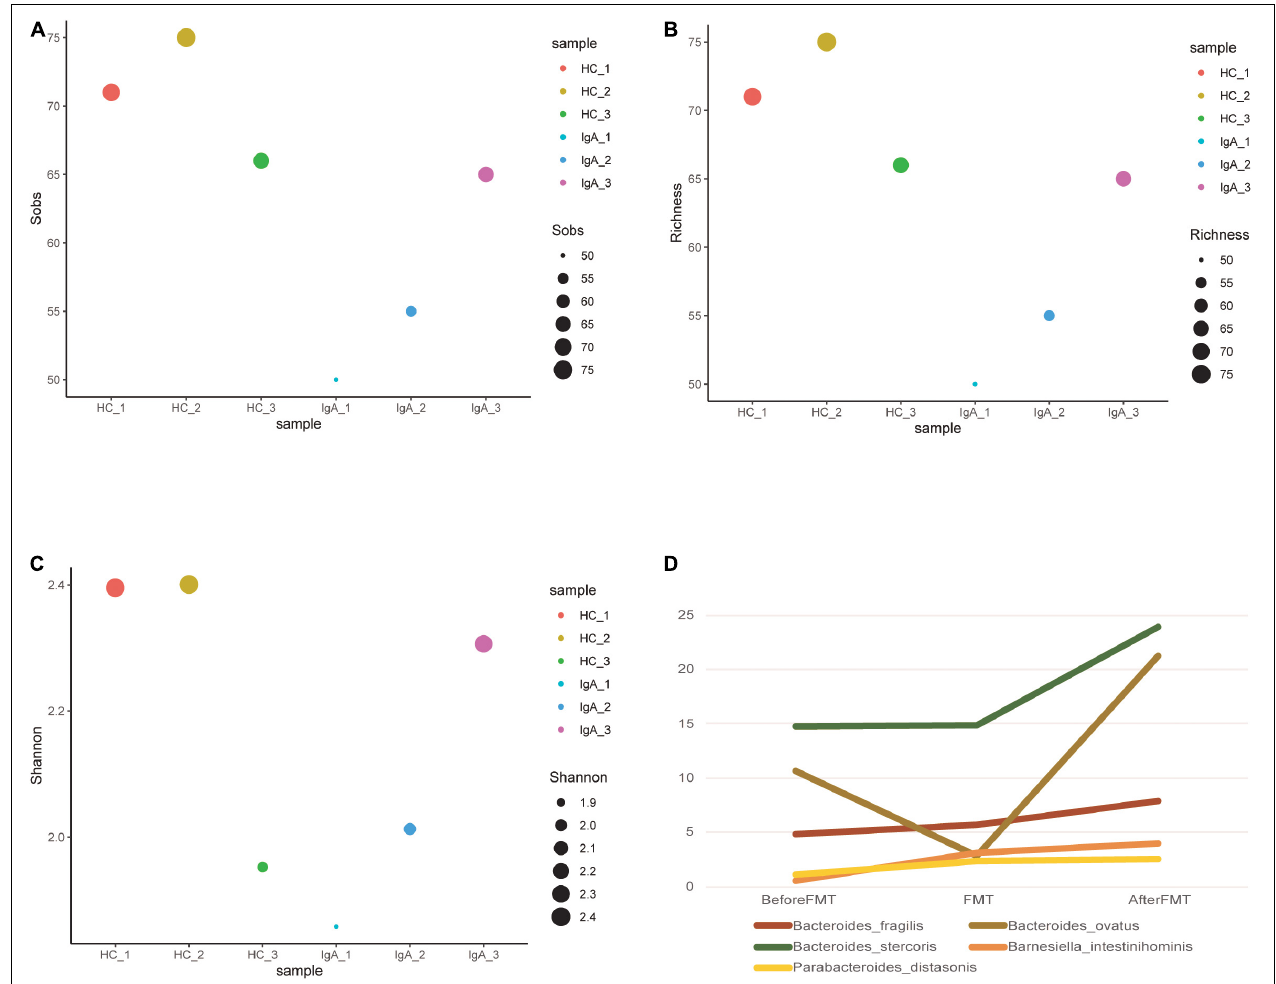
FIGURE 2 | Changes in alpha diversity and main bacterial species before and after FMT. (A–C) Were to show the diversity of IgAN patient and healthy control in this study. (A,B) Were to reflect the Richness, and (C) was to show the Evenness. The larger the point, the larger the value is. Different color means different samples before or after FMT. (D) Was to reflect the changes of main bacterial